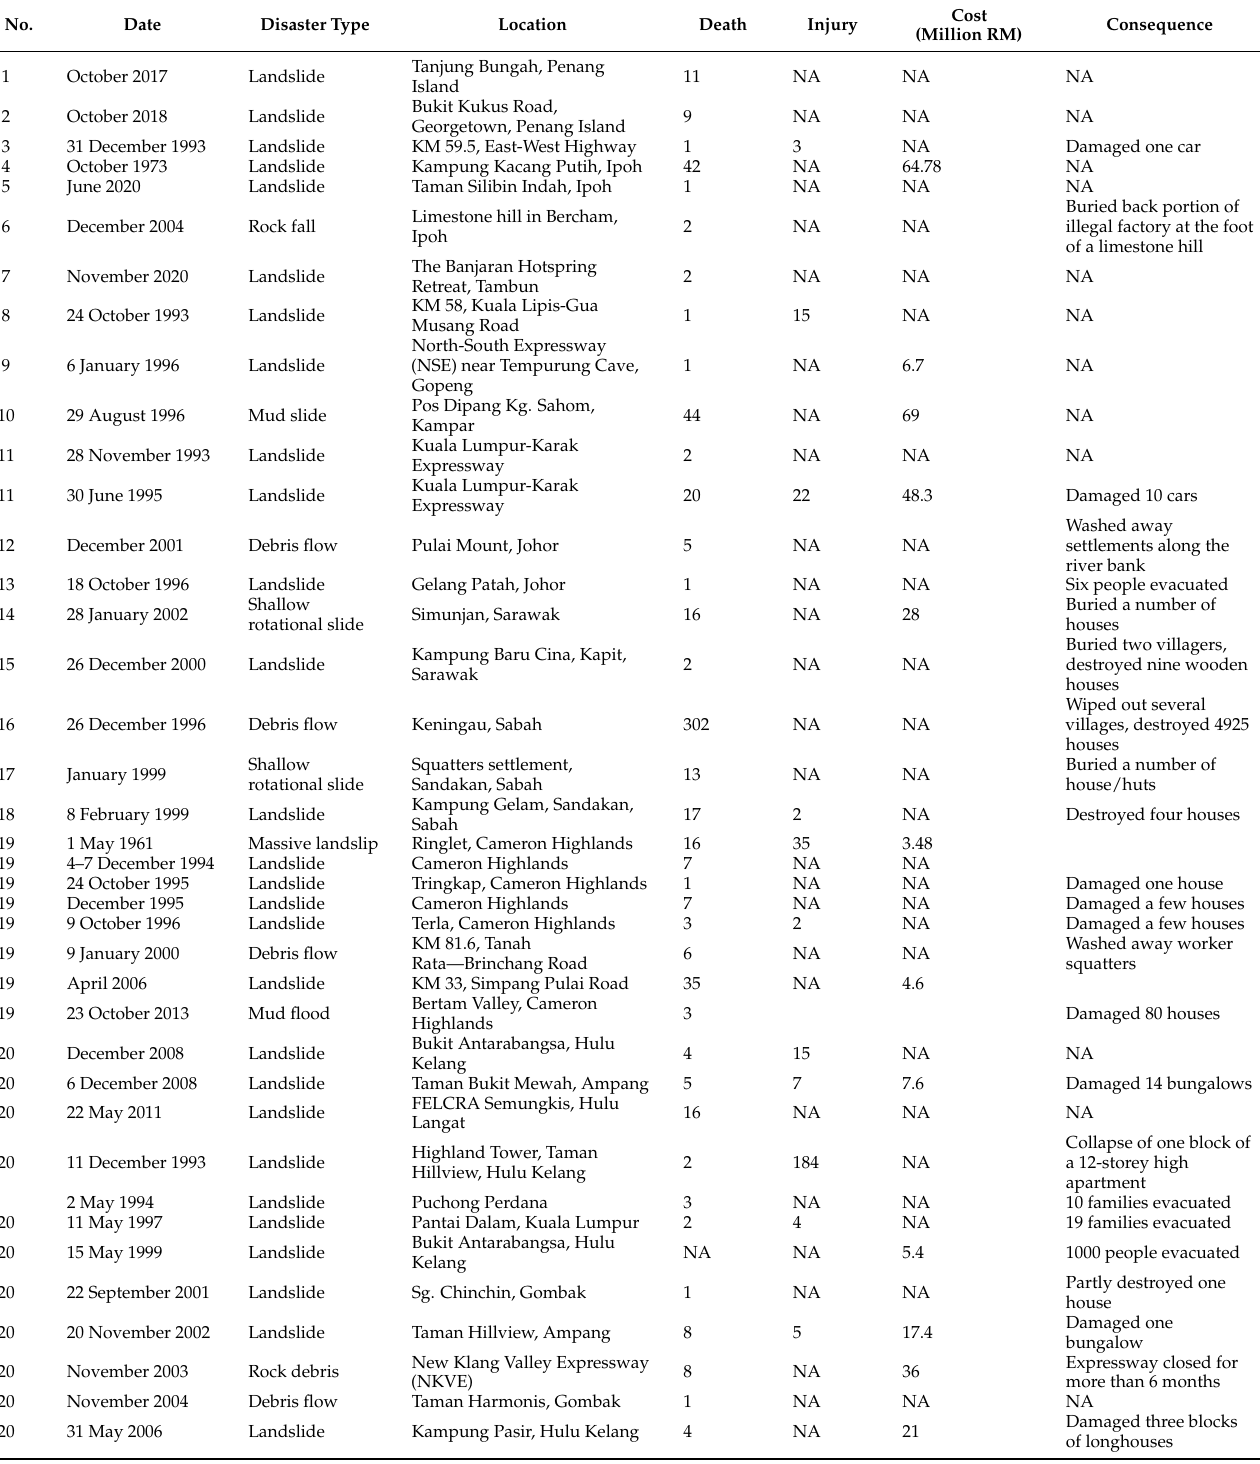
Table 1. Details of the historical summary of sediment-related disaster events in